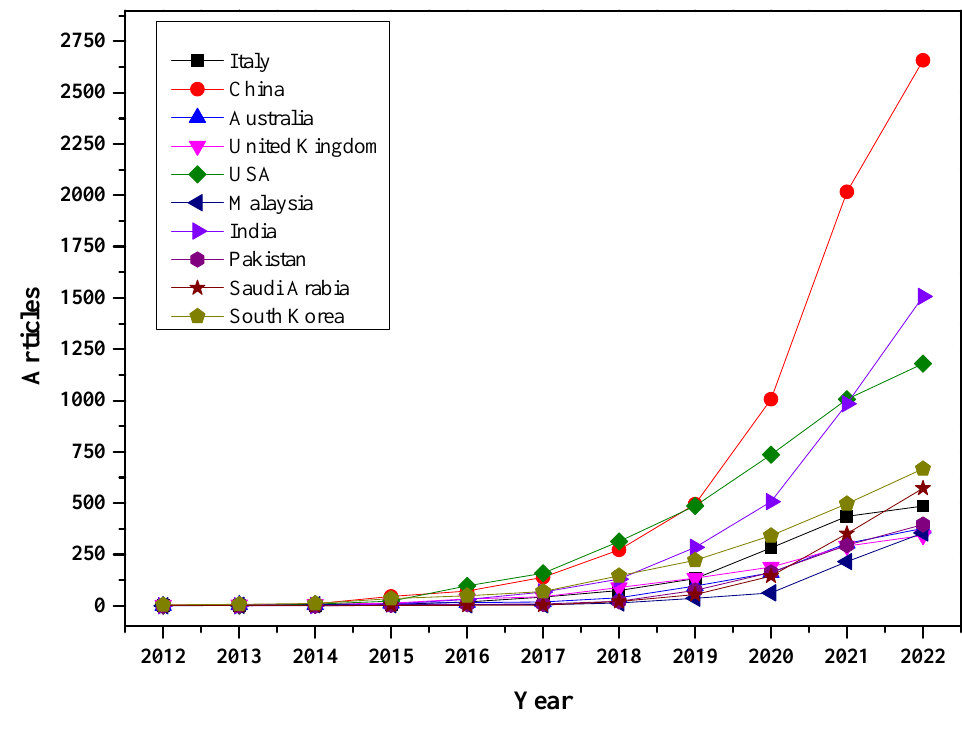
Figure 9. Production of top ten countries over time.